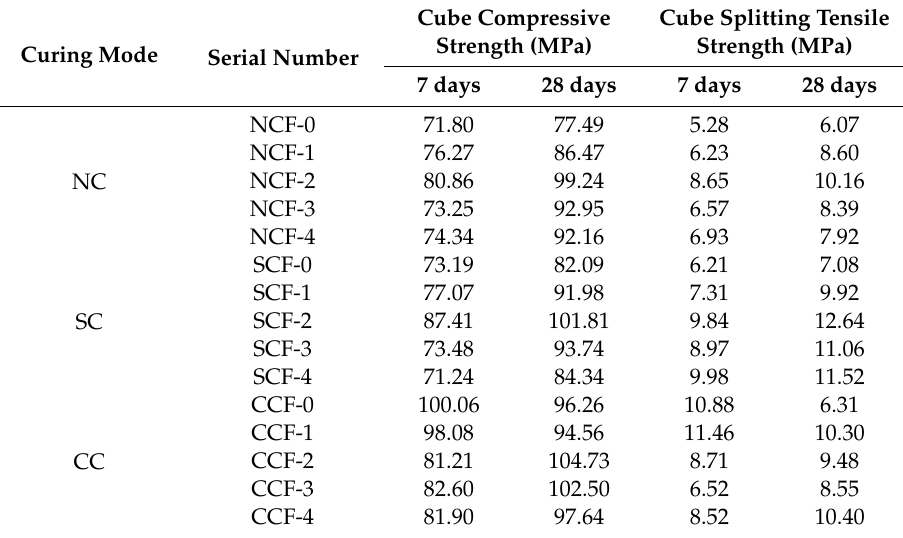
Table 8. Mechanical properties of carbon-fiber RPC.